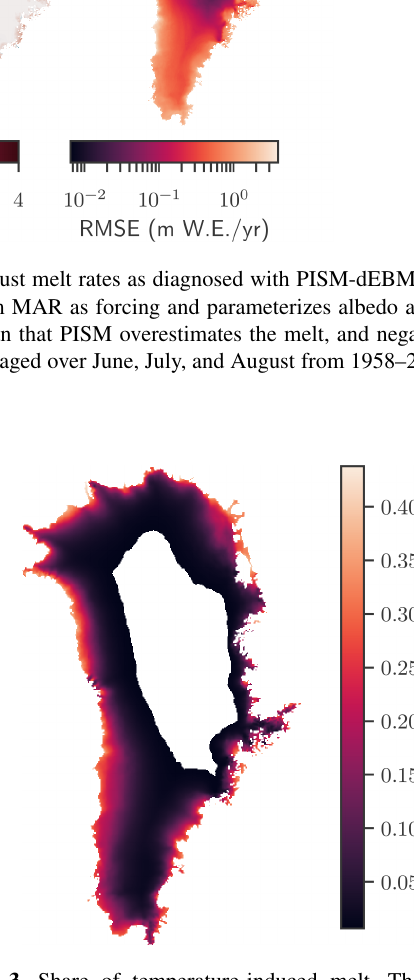
Figure 3. Share of temperature-induced melt. The fraction of temperature-induced melt, defined as M t /(M t + M i ) , is diagnosed with PISM-dEBM-simple and averaged over the months June, July, and August over the whole simulation period from 1958–2019. The white part in the centre illustrates areas of the Greenland Ice Sheet where the average melt is zero at